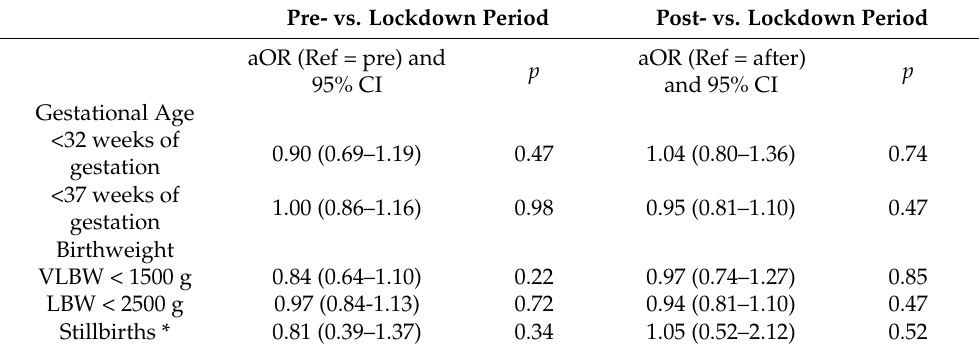
Table 3. Adjusted odds ratios (aORs) and 95% confidence intervals (CIs) for perinatal outcomes. Pre- vs. Lockdown Period